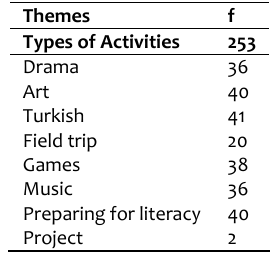
Table 5. Support activity types applied together with the science and mathematics activities